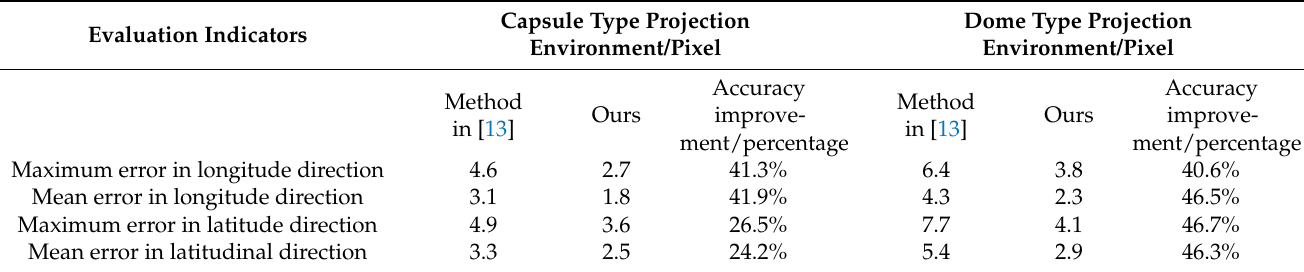
Table 2. Algorithm performance comparison